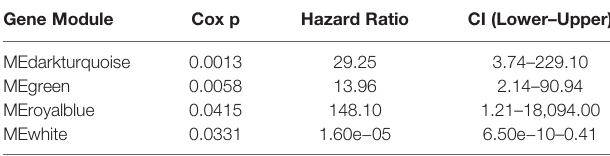
TABLE 2 | Gene modules with signi fi cant prognosis in